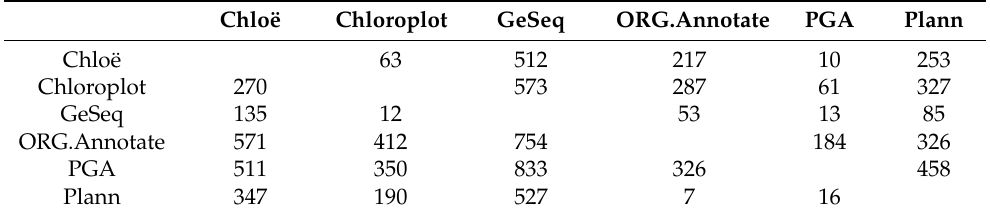
Table 7. Number of sequences where the row method identified longer IRs regarding the column